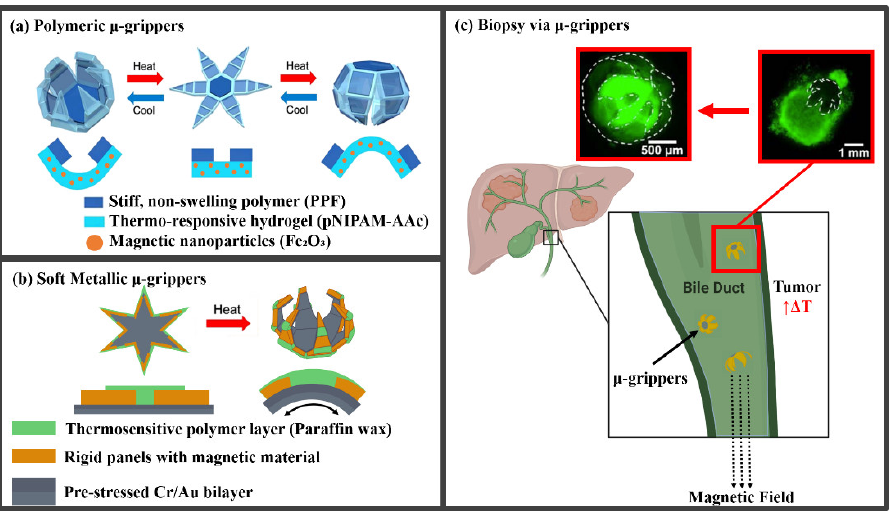
Figure 1. The use of polymeric and soft metallic thermomagnetic responsive microgrippers for minimally invasive biopsy. ( a ) Fully polymeric devices consist of a thermo-responsive poly(N-isopropylacrylamide-co-acrylic acid) (pNIPAM-AAc) hydrogel layer and stiff polypropylene fumarate (PPF) segments. The hydrogel layer swells or contracts when heated to above or below the transition temperature, causing the device to self-fold. Adapted with permission from Ref. [9]. Copyright 2015. ( b ) Soft metallic microgrippers consist of a pre-stressed bilayer of chromium and gold layered with rigid panels and thermosensitive paraffin wax hinges. The thermosensitive layer softens as the device reaches a temperature above normal body conditions, allowing the pre-stressed metallic layer to fold inward. Adapted with permission from Ref. [10]. Copyright 2014. ( c ) When exposed to the high-temperature regions of a tumor, the microgrippers can contract and grasp cells for a biopsy. Magnetic iron oxide particles in the porous hydrogel layer or magnetic materials in the rigid panels enable surgeons to use magnetic fields to control and retrieve the microgrippers with the excised tissue. Adapted with permission from Ref. [9]. Copyright 2015.